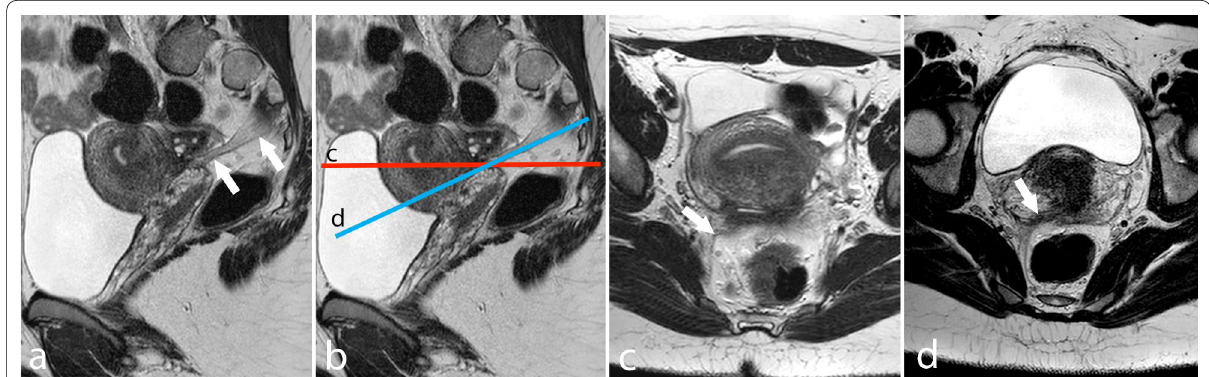
Fig. 1 Mild thickening of the right USL in a woman with DIE. a – b T2w sagittal images. c T2w axial image obtained along the red plane shown in b . d T2w oblique axial image obtained along the blue plane shown in b . The USL produces a better depiction of the sagittal and oblique axial plane